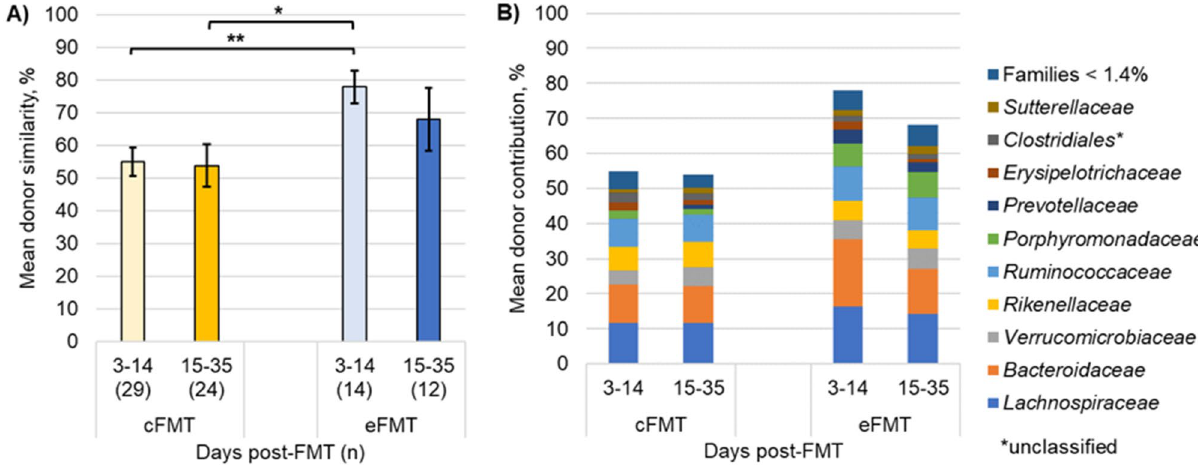
Figure 1. Engraftment of donor fecal bacteria determined using SourceTracker. ( A ) Mean (± standard error) percent of total donor engraftment. ( B ) Family-level distribution of OTUs associated with donor engraftment. Families with a mean < 1.4% of sequence reads among all samples were consolidated. * P < 0.05, ** P ≤ 0.01.